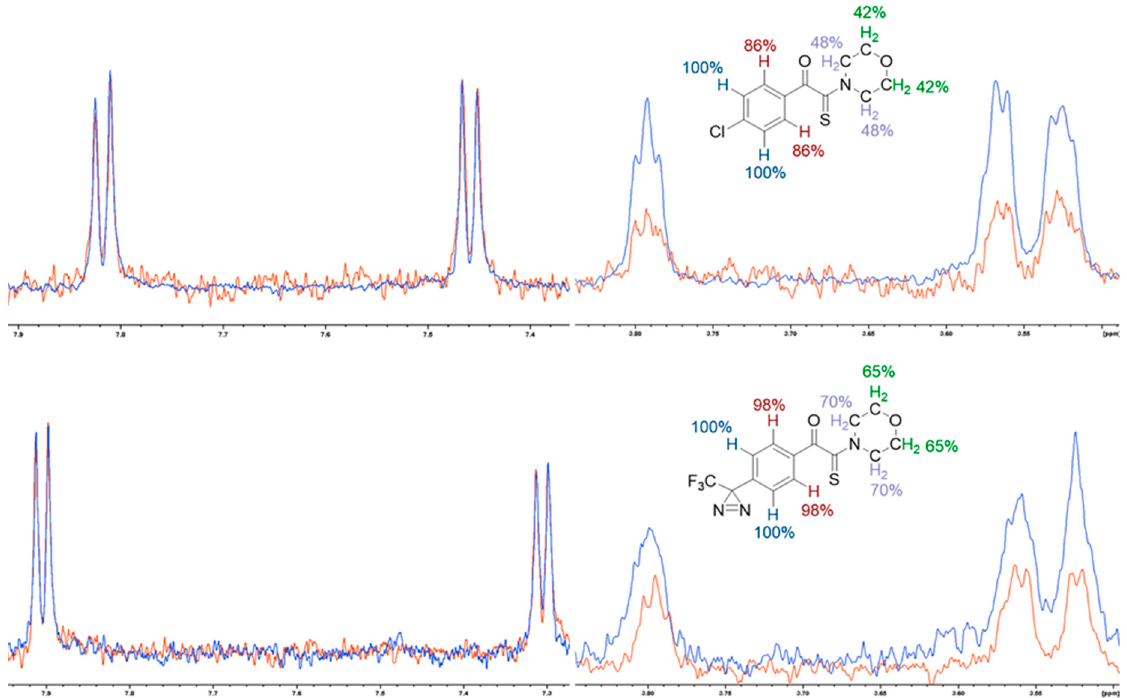
Figure 5. Epitope mapping of 11 and 2 . Superposition of 1 H (blue) and STD (orange) spectra of 2 (top, 100µM) and 11 (bottom, 100 µM) with PHGDH (10 µM). The percentages correspond to the relative integration of the STD spectra compared to the ones of the 1 H spectra. All spectra are scaled in regard to the aromatic protons. A reduction of the signal intensity in the STD spectrum compared to the 1 H spectrum indicates a lower saturation transfer and hence a weaker interaction.